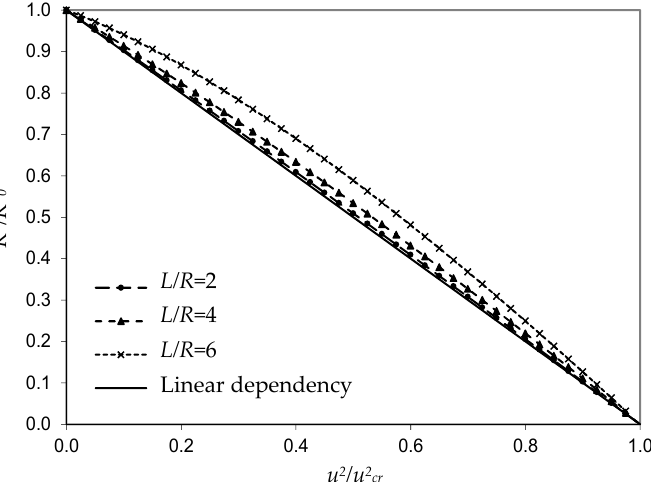
Figure 5. Dependences of normalized values of non-dimensional stiffness K ’/ K ’ 0 on normalized values u 2 / u 2 cr for the rigid–rigid connection.